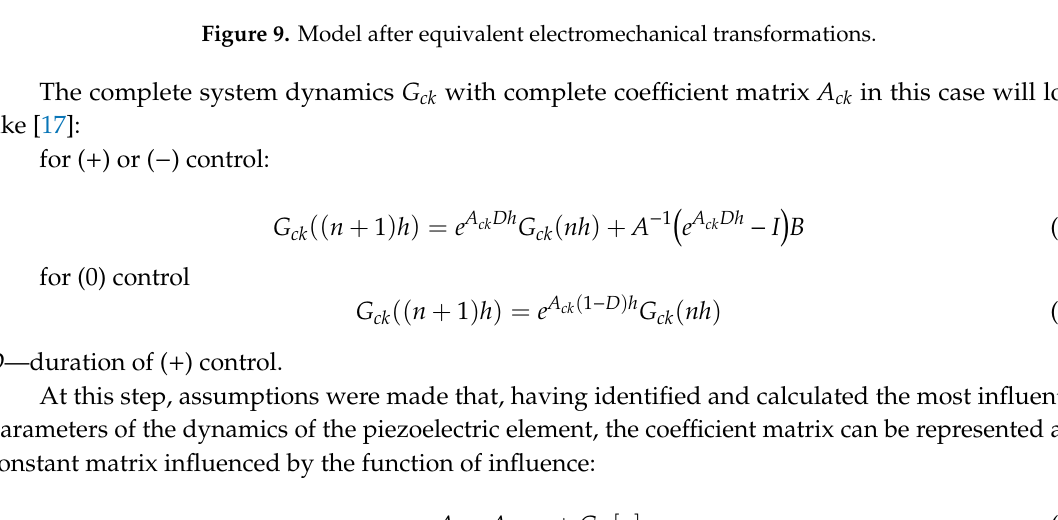
Figure 9. Model after equivalent electromechanical transformations.